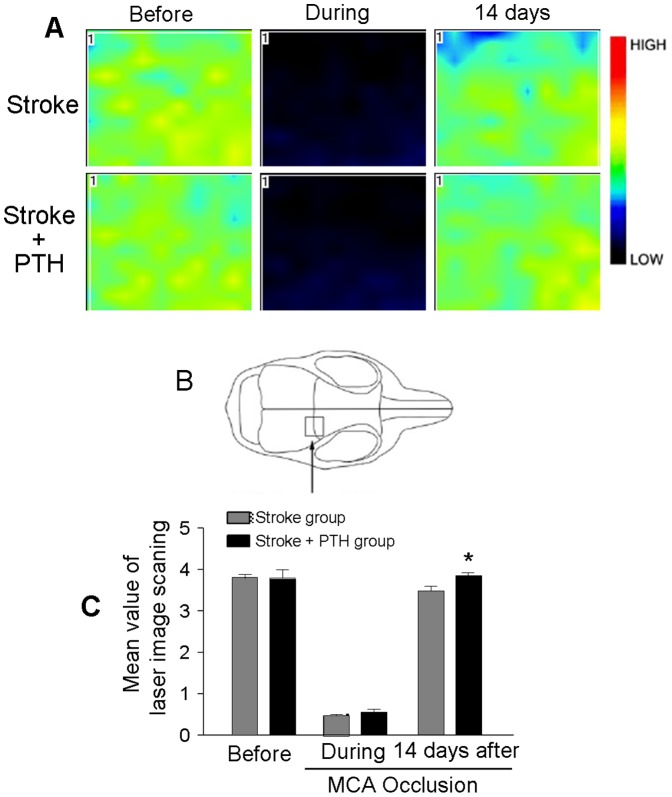
Recovery of local cerebral blood flow in the ischemic cortex.Local cerebral blood flow was measured using the PeriScans laser image scanner 14 days after stroke. A. Laser scanning images of LCBF in stroke/saline mice and stroke/PTH treatment mice before, during and 14 days after MCA occlusion. B. Sketch of the mouse skull showing the imaging area (square frame with arrow) for LCBF. The total scan area was 5.76 mm2. C. Quantification of LCBF measurements using the laser Doppler scanner. In this focal ischemia model of barrel cortex stroke, LCBF could largely recover 14 days after stroke. A greater recovery was seen with PTH treatment. N = 8 animals in each group; * P<0.05 vs. stroke control.